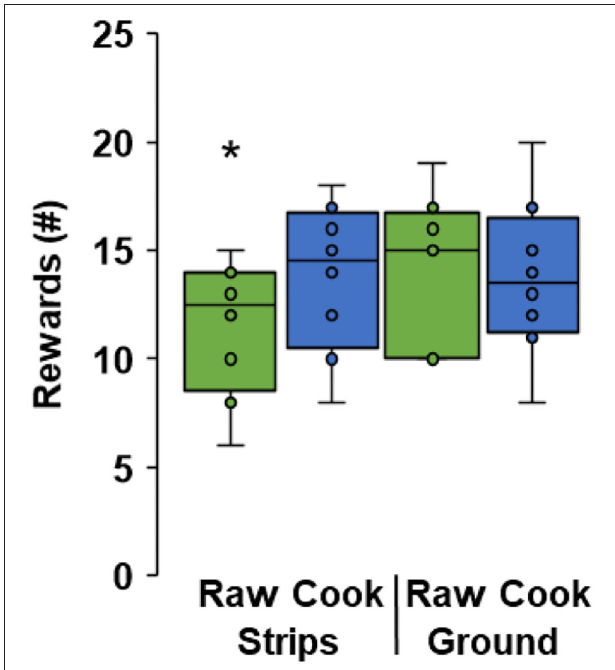
FIGURE 5 | Boxplots for the number of rewards obtained by lever pressing for kibbles. Cats ( n = 8) were adapted to raw or cooked meat fed in strips (1 × 1 × 2cm) or ground (particle size ≤ 2mm) and tested for food motivation 3h after their morning meal. Boxes show the interquartile ranges, whiskers show the minimum and maximum values, and the asterisk indicates difference between raw stripped meat and other treatments ( P = 0.014 for grinding ×